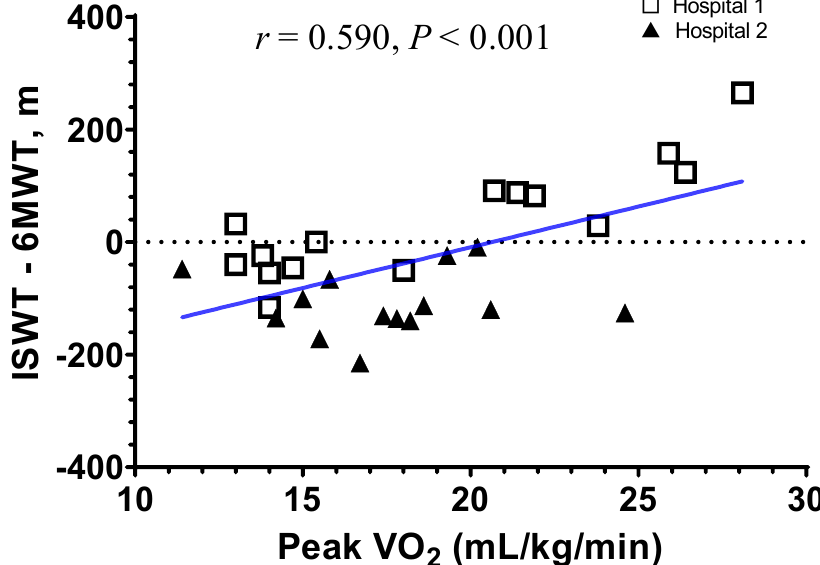
Figure 4. The correlation between peak VO 2 and the difference of walking distance between ISWT and 6MWT. The correlation coefficient ( r ) was analyzed using Pearson’s correlation. Patients with higher peak VO 2 walked a longer distance in ISWT than 6MWT. Abbreviations: 6MWT, 6 min walk- ing test; ISWT, incremental shuttle walking test; peak VO 2 , peak oxygen